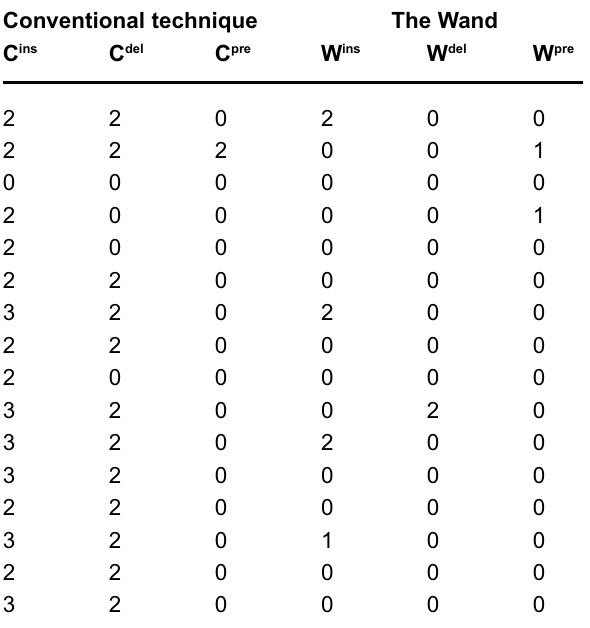
TABLE 2- VRS pain data from conventional and Wand anesthesia techniques